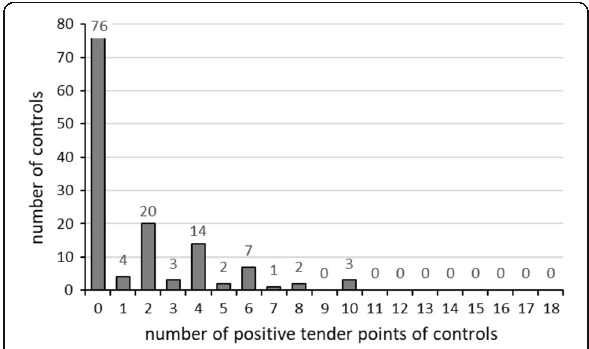
Fig. 1 Distribution of number of positive tender point of controls. The cutoff value for WPH responder was defined as the total TPC below which 95% of control subjects responded. This cutoff value was 7